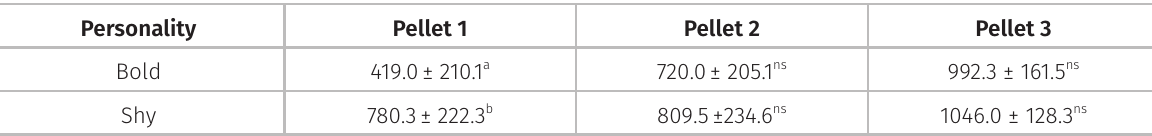
Table II. Mean time (s) that Nile tilapia ( Oreochromis niloticus ) of different personalities spent to consume the different pellets in the food competition test.